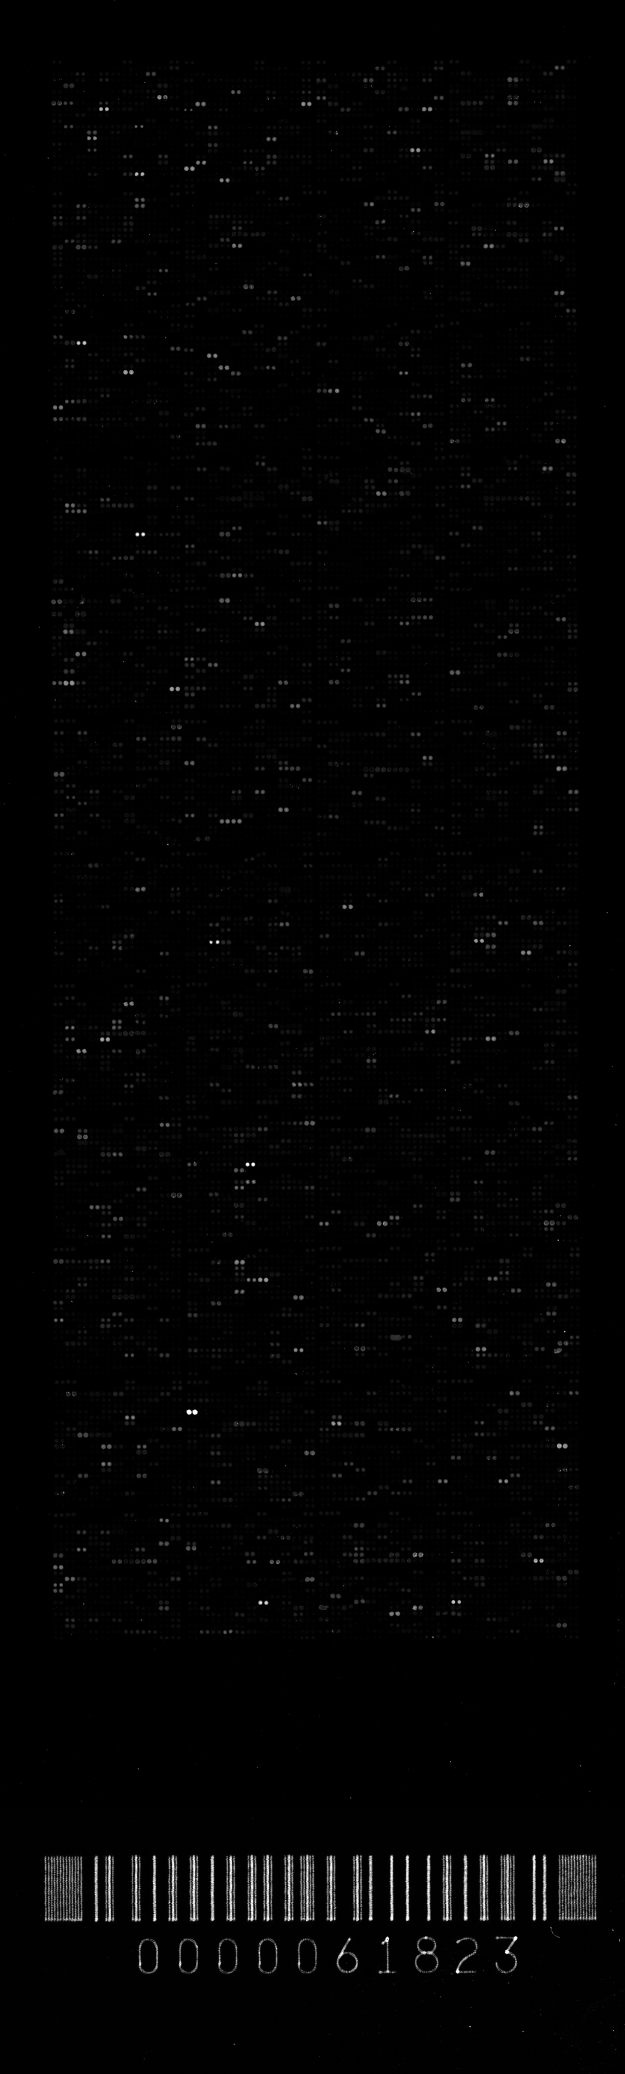
High Resolution Array Image. Experimental assay with G4-1, profiled at 25 μM.